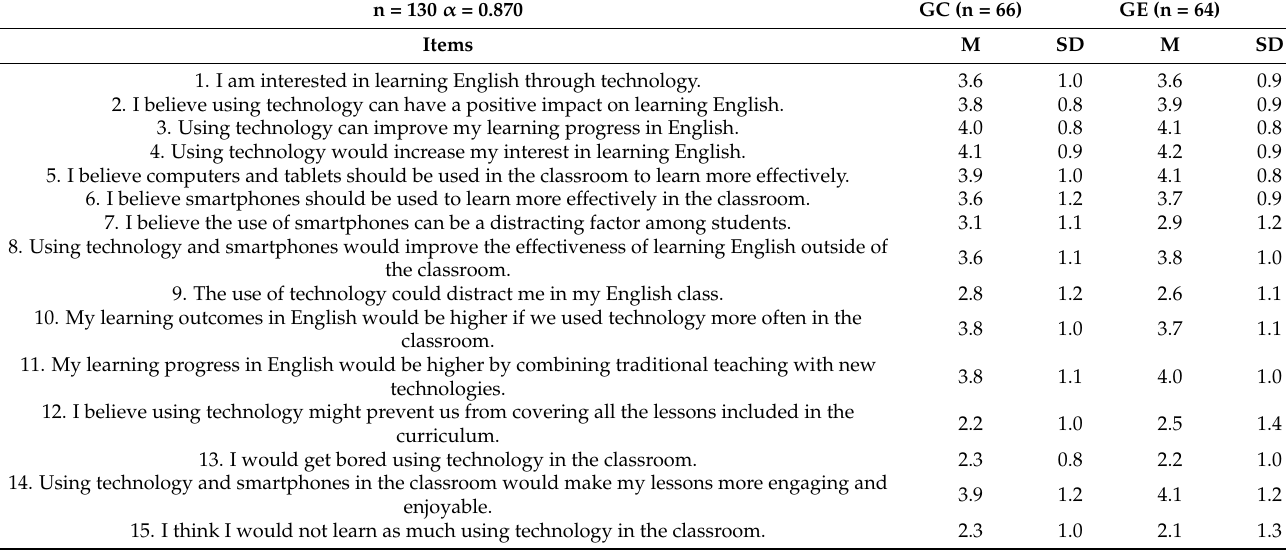
Table 3. Perception toward the use of technology in language learning based on a 5-point Likert